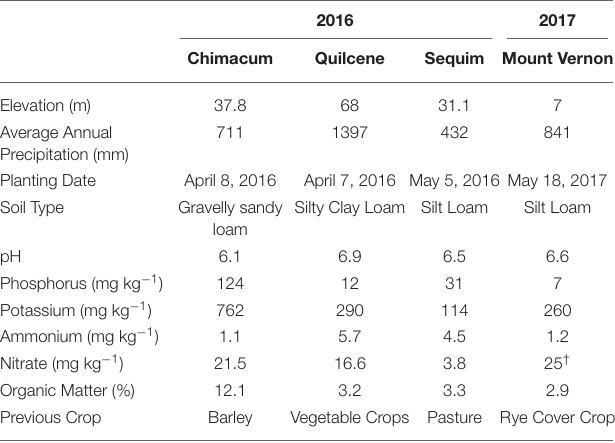
TABLE 1 | Site characteristics for each year and location that samples were randomly selected from for chemical analysis. Raw quinoa seed sent for analysis was grown in 2016 and 2017 in western Washington as part of two separate experimental designs (13, 49).